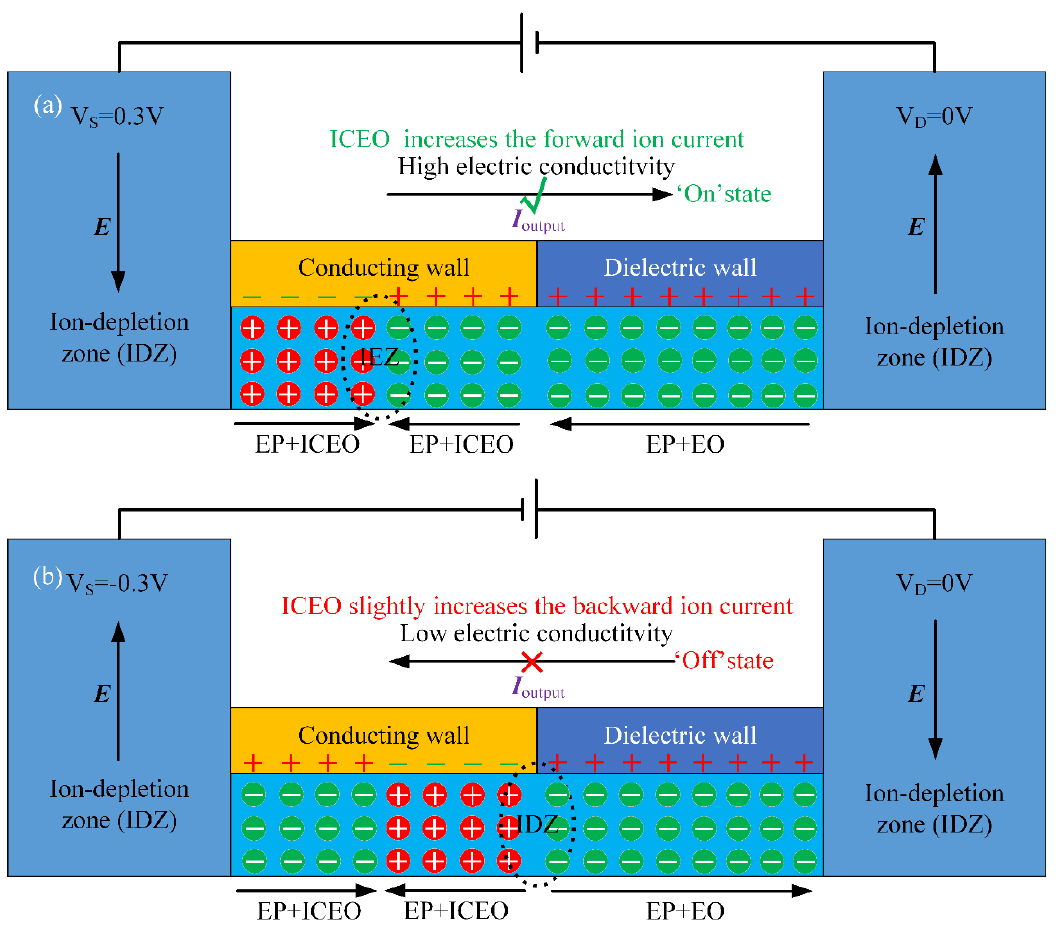
Figure 3. A 2D cross-sectional schematic diagram of the nanofluidic ion diode exploiting ICEK-mediated internal ICP in a metal-dielectric Janus nanopore for achieving reliable ion current rectification in the r-z axisymmetric coordinate system, in which the dielectric wall is positively charged and serves as an anion-selective medium. Under an external DC electric field, the combination of a bipolar induced double layer (IDL) within the metallic nanochannel and unipolar cations within the positively-charged dielectric nanochannel gives rise to a voltage-adjustable non-uniform space free charge distribution, whose electrochemical transport along the nanopore results in ( a ) an ion-enrichment zone (IEZ) in the center of the conducting wall for a positive DC bias and therefore the “on” working state of the ion circuit platform with the forward electric current being greatly enhanced and ( b ) an ion-depletion zone (IDZ) in the midchannel for a negative DC bias and thereby the “o ff ” working status of the nanofluidic ion diode with the backward current being greatly weakened.